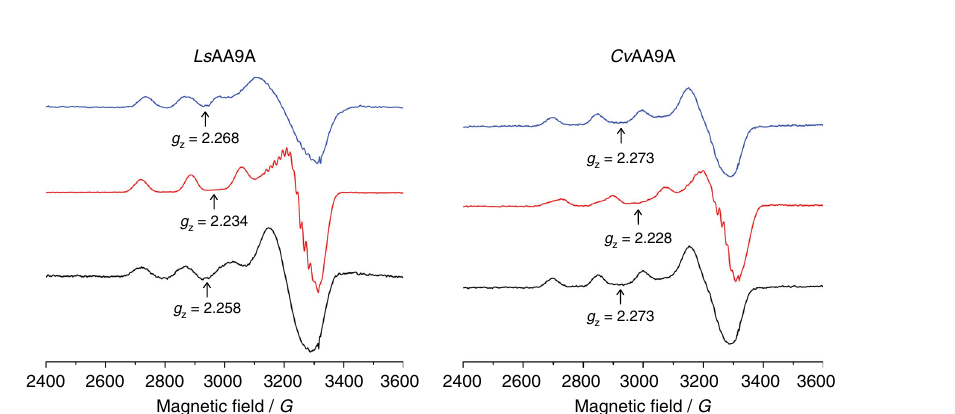
Fig. 7 X band cw EPR spectra of Ls AA9A (left) and Cv AA9A (right), 150 K. Spectra were collected in the presence of 1 M NaCl (black), Cell 6 and 200 mM NaCl (red), or Xyl 6 and 1 M NaCl (blue). Spectra are representative of duplicate experiments